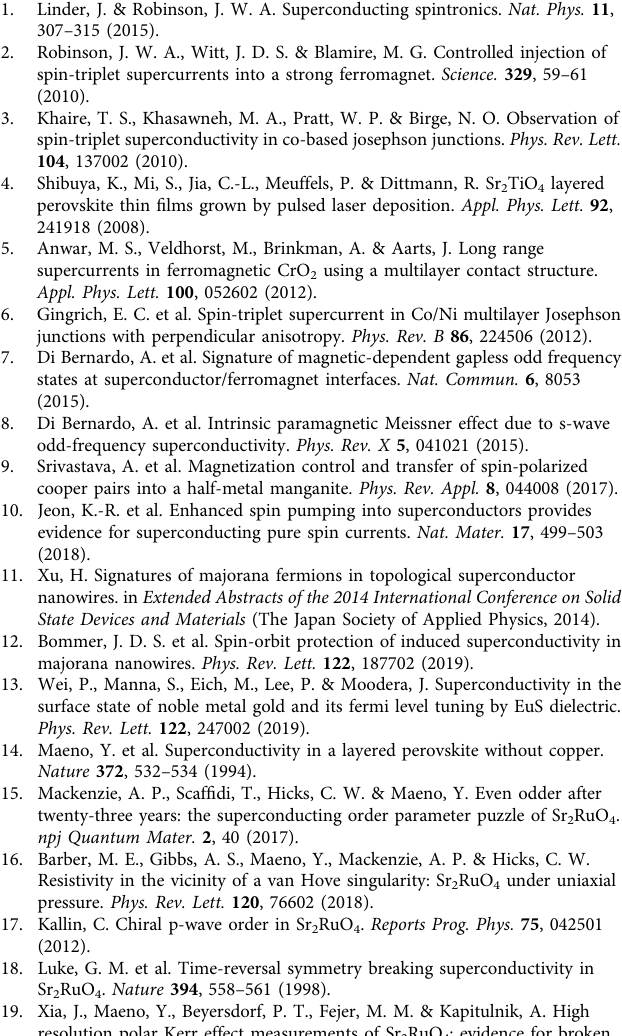
Fig. 4 Nature of dislocations and their effect on superconductivity in Sr 2 RuO 4 fi lms. a An illustration of an edge dislocation with an out-of-plane line vector u (grey arrow) and Burgers vector b in-plane (orange arrow) on the ( h 0 0) planes of SRO 214 . The diagram also shows the X-ray diffraction setup in edge geometry (Tilt angle of the sample stage χ offset = 90 ˚ ) to measure the in-plane misorientation, twist, from the peak broadening in ω (angle between the X-ray incident beam and the diffracted planes) due to variations in the scattering direction (white and yellow arrows). Transmission electron microscopy TEM g (cid:1) b analysis to reveal edge dislocations using bright fi eld imaging with two perpendicular diffraction conditions ( g and g h ) is also 00 l 00 shown. b Degree of twist versus thin- fi lm thickness t , determined from the full width half maximum in ω FWHM ω , measured from χ offset ~ 78 ˚ in skew symmetric on the (4 1 3) planes (inset curves are vertically offset for clarity). c , Superconducting critical temperature T c versus and resistivity ρ versus twist (inset). d – o g (cid:1) b analysis by bright fi eld TEM showing dislocations on three areas of a lamella from metallic ( d – i ) and superconducting ( j – o ) SRO 214 fi lms (marked as three asterisks in b and c ). The diffraction vectors g and g h are indicated by green arrows and b by orange arrows: for in-plane edge 00 l 00 dislocations the arrows are horizontal, for out-of-plane screw dislocations the arrows are vertical, and for mixed dislocation the arrows are tilted. The interface fi lm/substrate interface is marked with a yellow dotted line. Scale bar in d – o ,